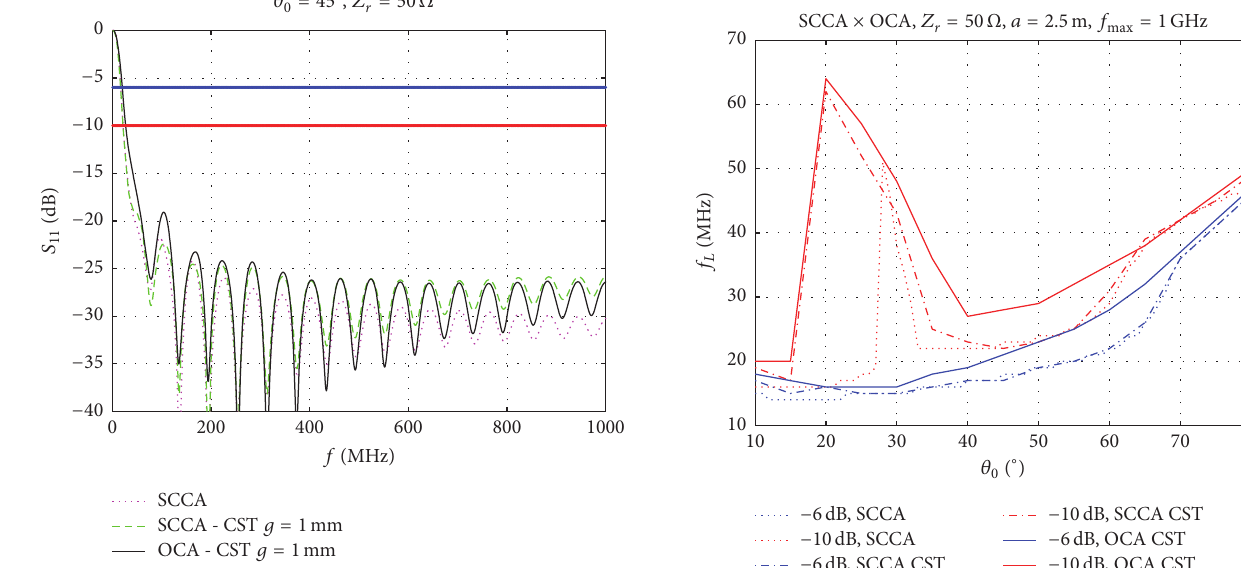
Figure 17: 𝑓 𝐿 × 𝜃 0 chart for the theoretical SCCA and the CST simulated SCCA and OCA for 𝑍 𝑟 = 50 Ω